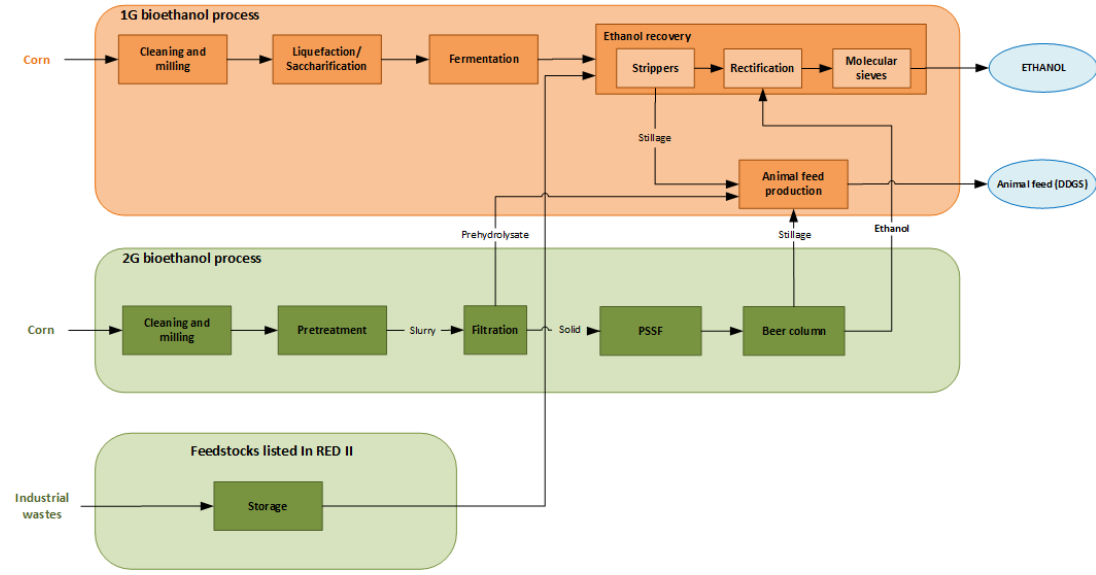
Figure 8. Descriptive flow sheet of the scenario 2.